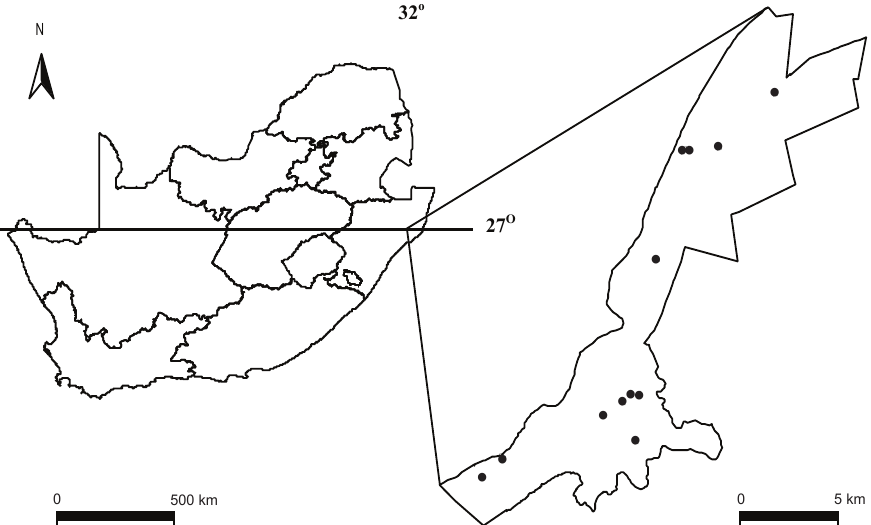
Fig. 1. Phinda Private Game Reserve. Black dots indicate the position of sites where artificial feed was provided during the winter of